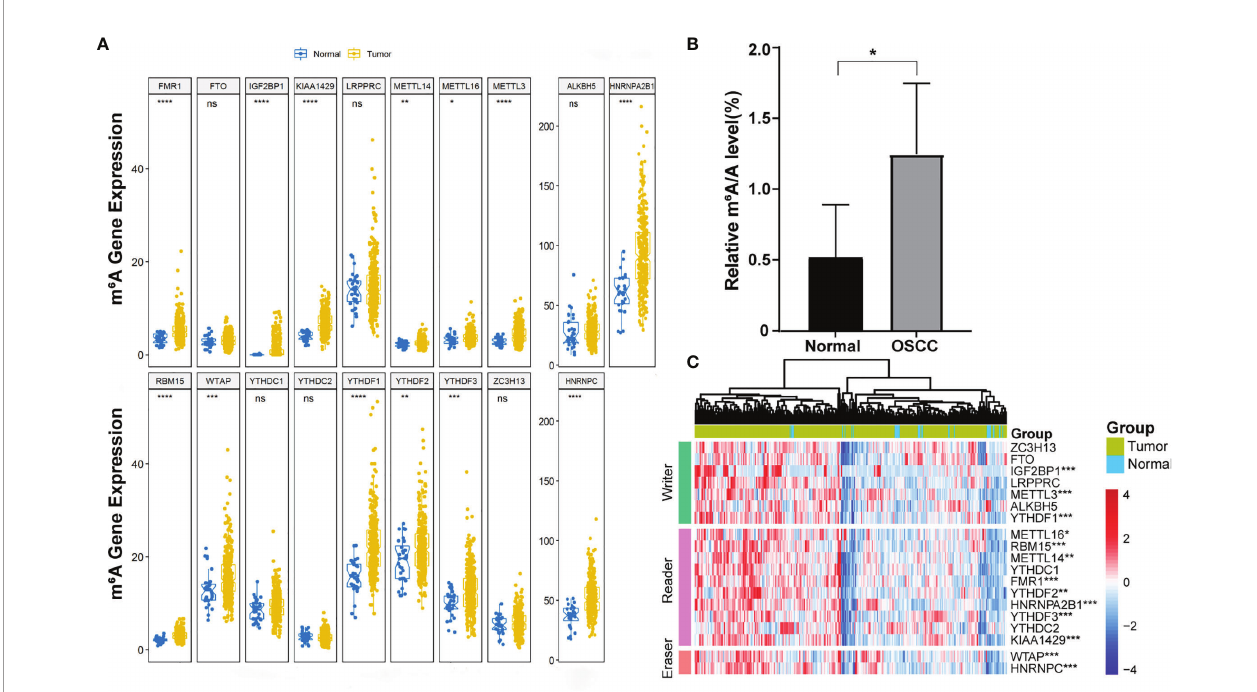
FIGURE 1 | The expression of 19 m 6 A-related genes in OSCC. (A) Boxplot visualizing the expression of m 6 A-related genes in 330 OSCC samples and 32 normal samples. (B) m 6 A level was detected in six pairs of OSCC tissues and adjacent normal tissues ( p < 0.05). (C) The expression levels of 19 m 6 A-related genes in OSCC were displayed via a heatmap. The ascending normalized expression level in the heatmaps is colored from blue to red. *, **, *** and **** indicated p<0.05, p<0.01, p<0.001 and p<0.0001, respectively. “ ns ” indicates no signi fi